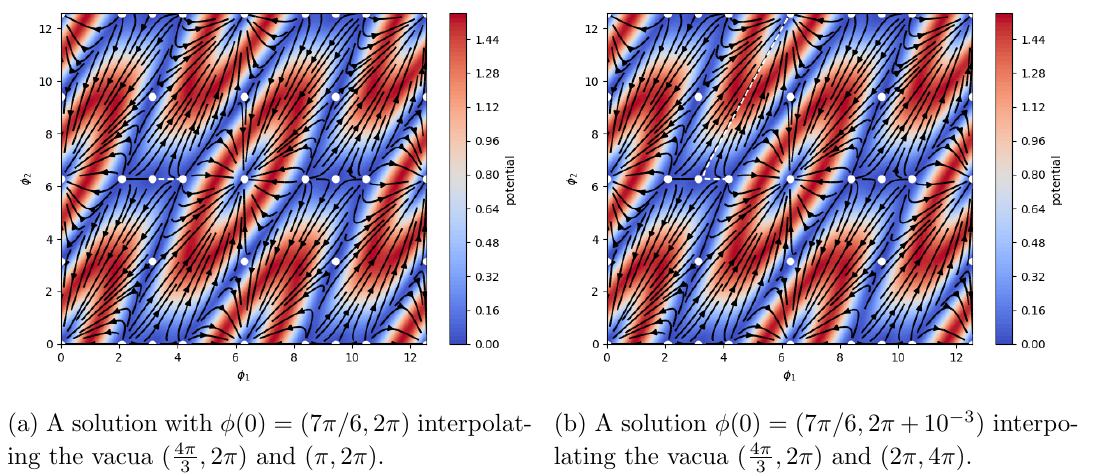
(a) A solution with (cid:30) (0) = (7 (cid:25)= 6 ; 2 (cid:25) ) interpolat- (b) A solution (cid:30) (0) = (7 (cid:25)= 6 ; 2 (cid:25) + 10 (cid:0) 3 ) interpo- ing the vacua ( 4 (cid:25) ; 2 (cid:25) ) and ( (cid:25); 2 (cid:25) ). lating the vacua ( 4 (cid:25) ; 2 (cid:25) ) and (2 (cid:25); 4 (cid:25) ). 3 3 Figure 7. BPS states constructed using slightly di(cid:11)erent initial conditions. A small change of order 10 (cid:0) 3 in the value of (cid:30) 2 implies a dramatic change in the resulting con(cid:12)gurations.